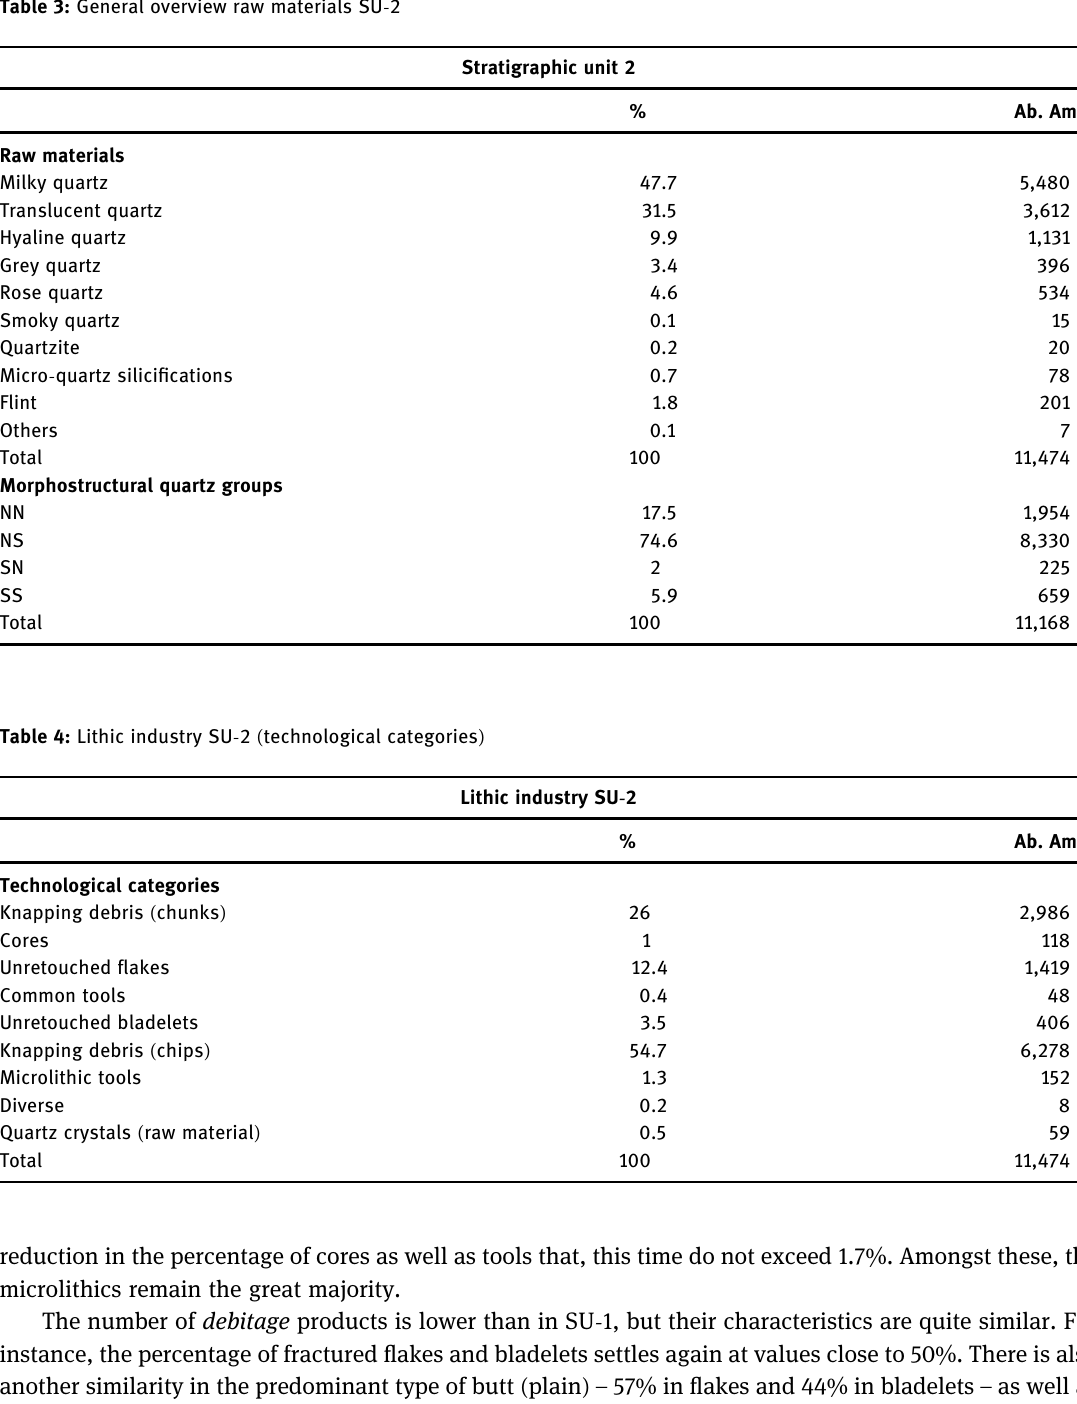
Table 3: General overview raw materials SU -